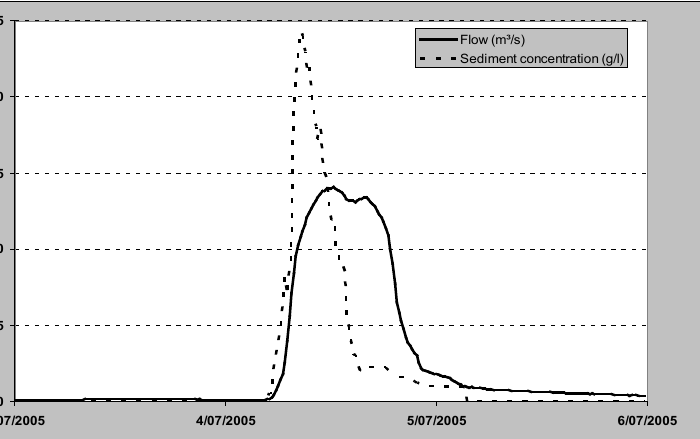
Fig. 3 Flow and sediment concentration on the Maarkebeek (downstream) during the 04/07/2005